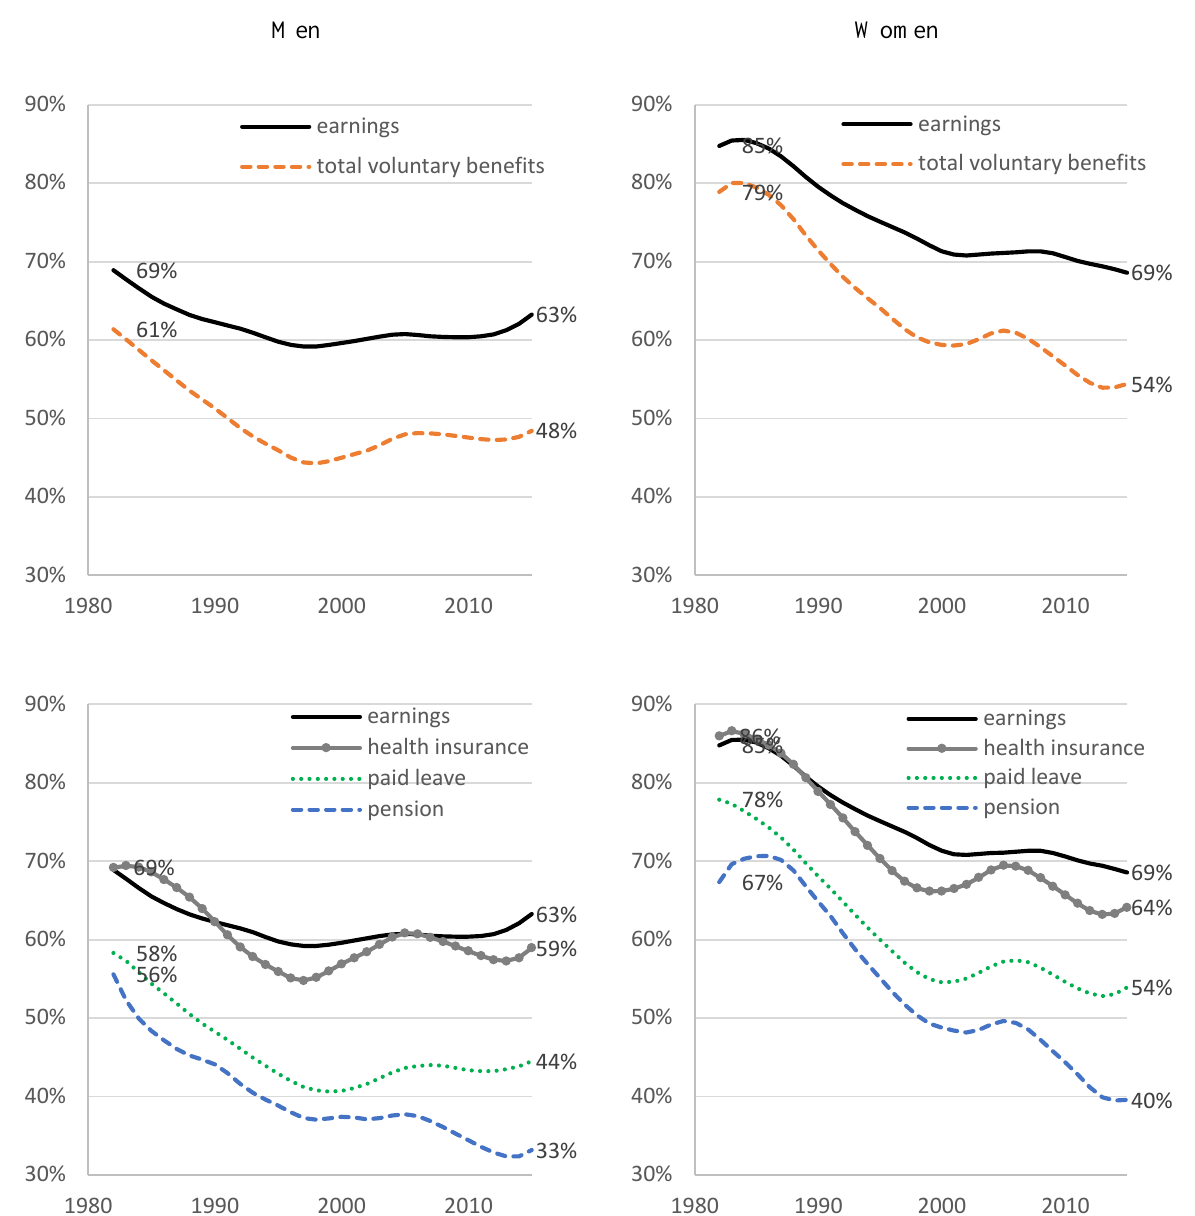
Figure 6: Hispanic-to-White Health Insurance, Pension, Paid Leave, Total Voluntary Benefits and Earnings Ratio (Percentages), 1982-2015